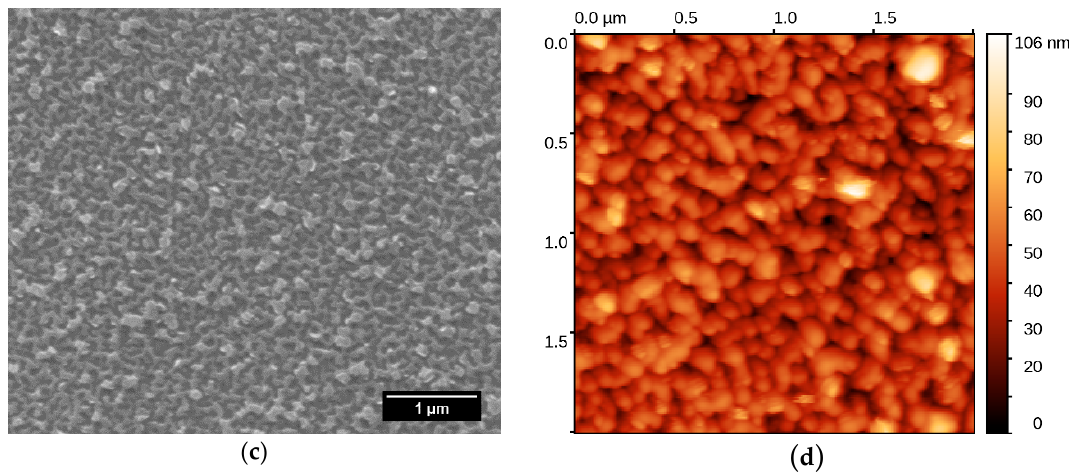
Figure 4. Zn-DLC sample with 38.9 at.% Zn: ( a ) SEM image of the sample as prepared; ( b ) SEM image of the sample as prepared, with higher magnification; ( c ) SEM image of the sample after etching; ( d ) AFM image of the etched surface.